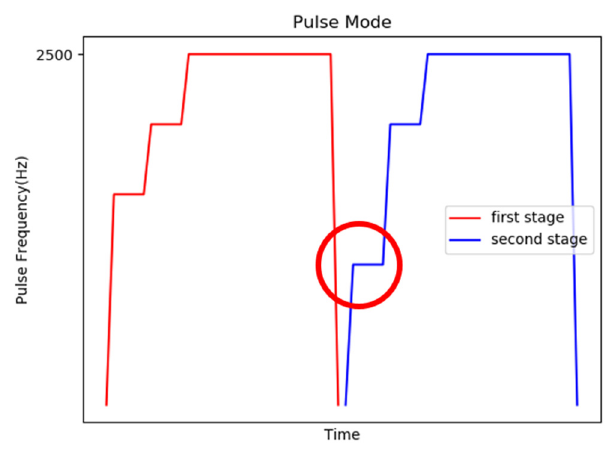
Figure 15. Schematic diagram of the first control mechanism.